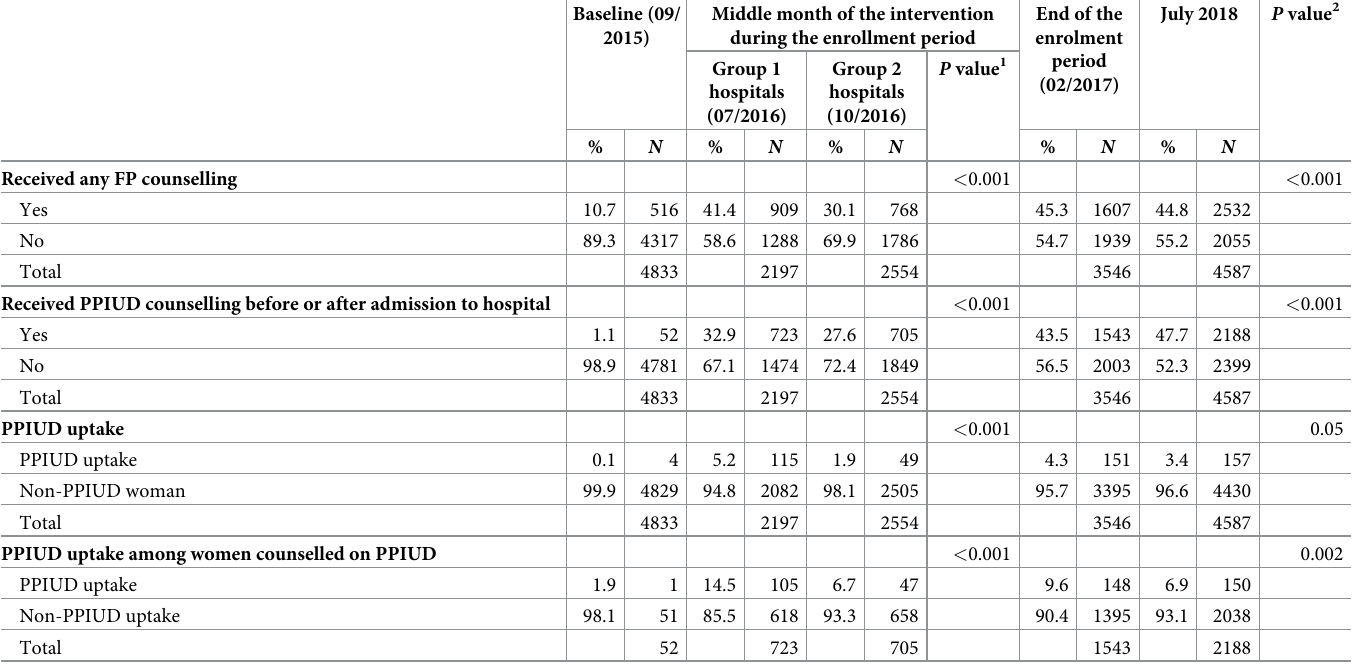
Table 3. Percentage of women receiving PPIUD counselling and PPIUD uptake,